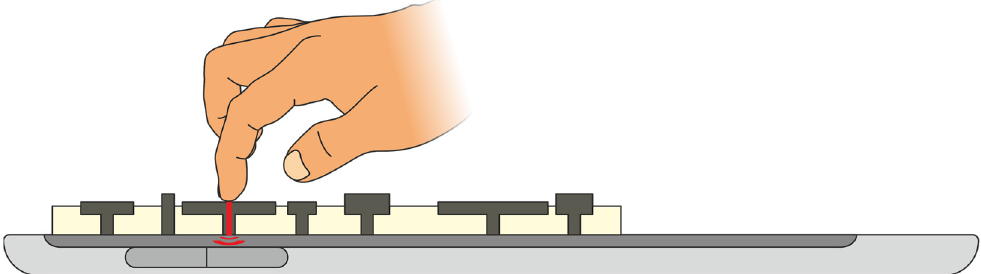
Figure 3. TouchIt3D technology principle when touching an interactive map symbol.